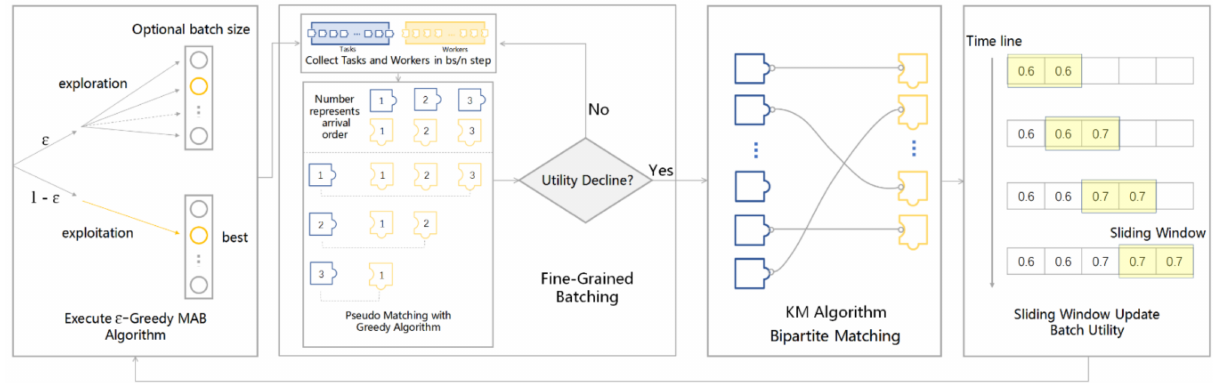
Figure 1. Algorithmic